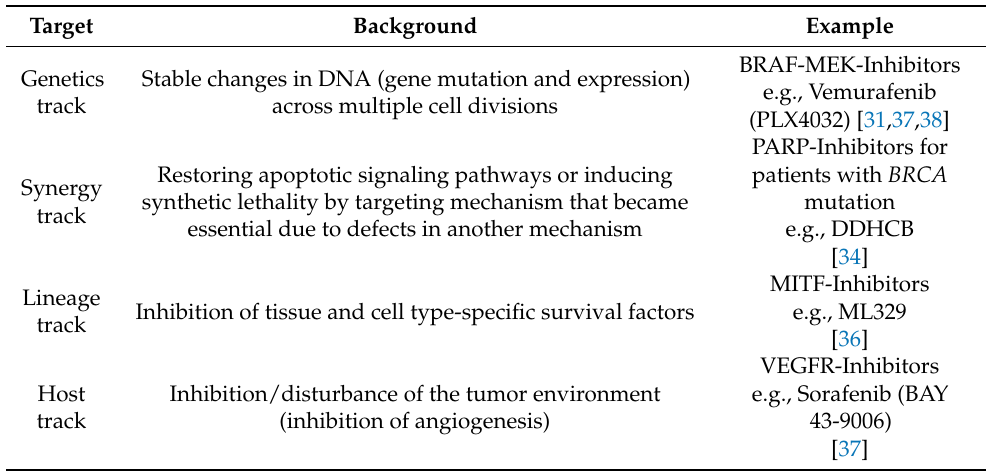
Table 1. Different tracks for targeted therapies using small molecules according to Benson et al.